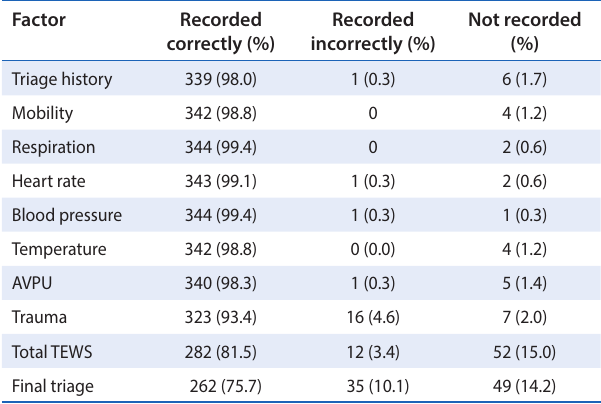
Table 1: Comparison of the triage history and TEWS with patients’ clinical notes